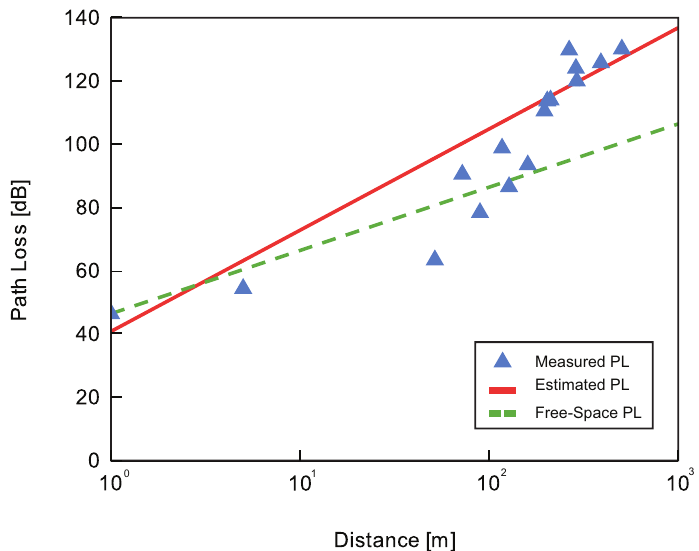
Figure 6. Estimated and measured PL compared with the FS model in the farm